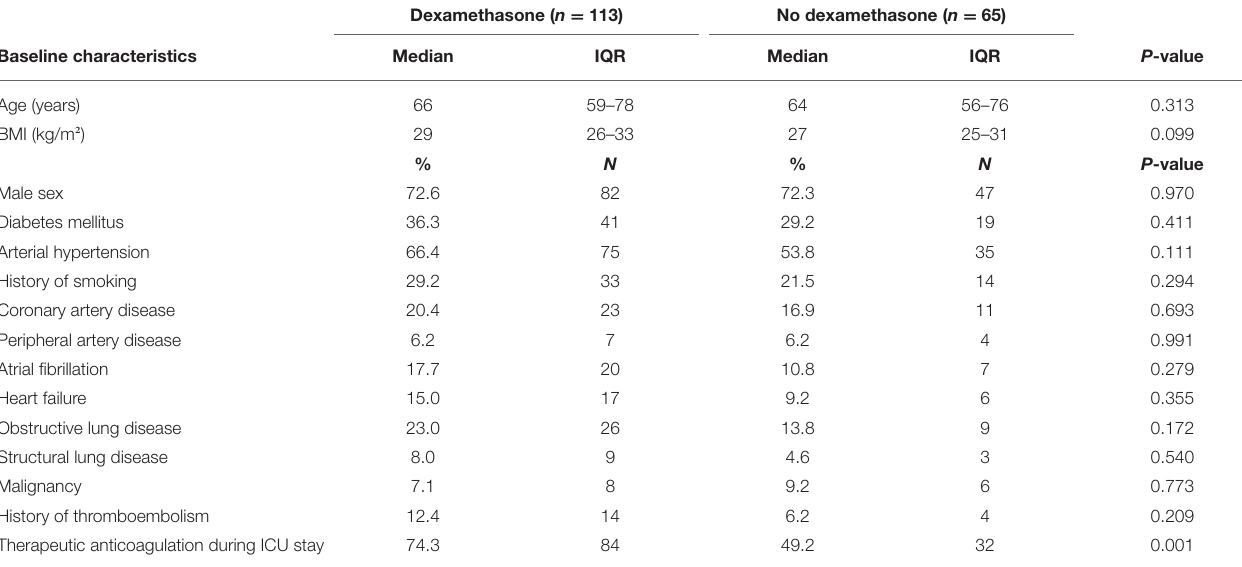
TABLE 1 | Baseline characteristics and comorbidities of patients within the two subgroups. Dexamethasone ( n =